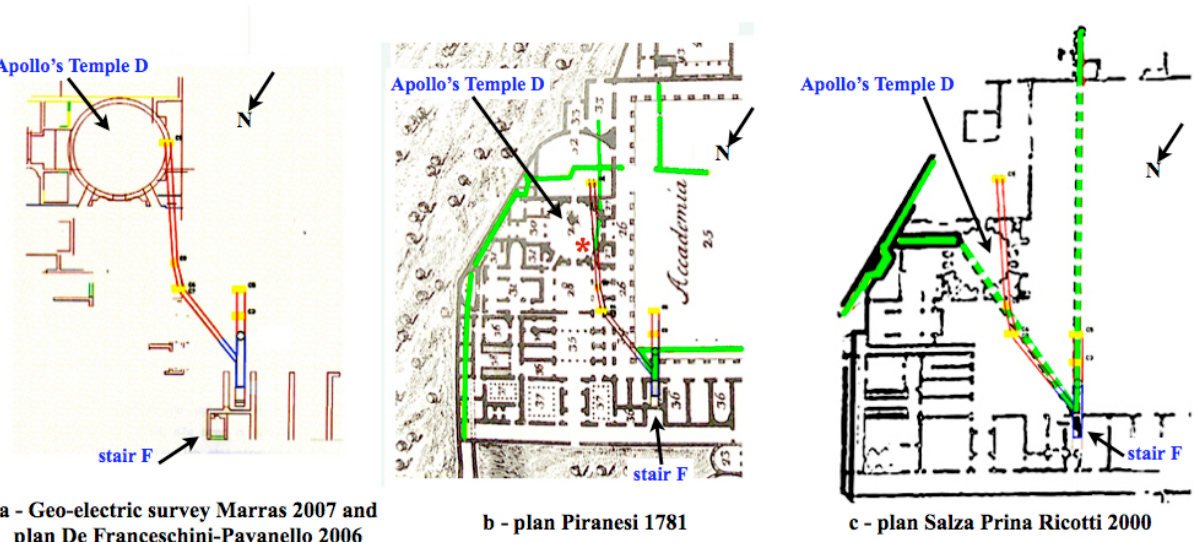
Fig. 14. Comparing our new plan (by A. M. Marras) with the previous ones. (a) layout of the tunnels superimposed to our new plan; (b) the same over the plan by Piranesi: the asterisk shows where our tunnel connects to the one drawn by Piranesi under the Apollo’s Temple; (c) over the plan by Salza Prina Ricotti: her layout (in green) was proven wrong for the left branch of the tunnel.